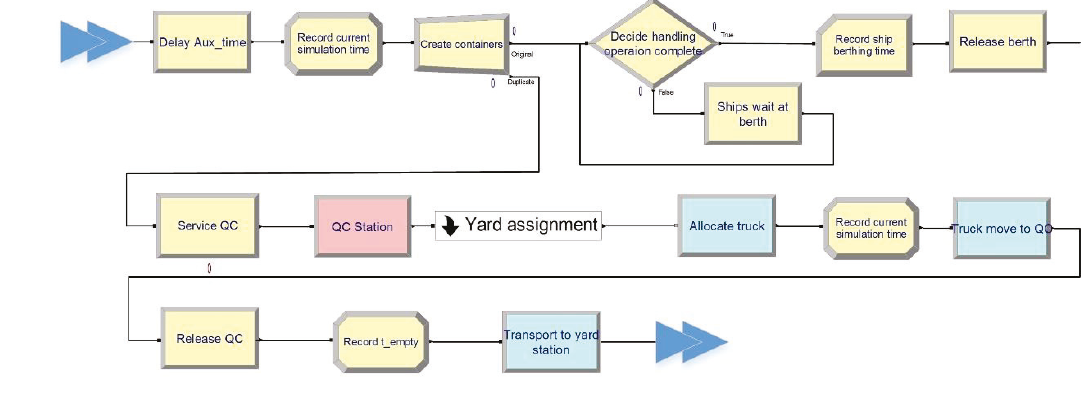
Figure 6: The handling submodule.